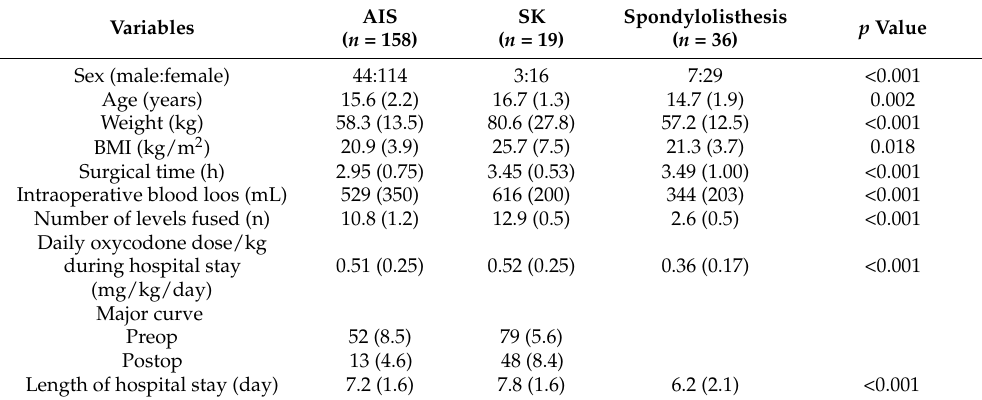
Table 1. Demographic